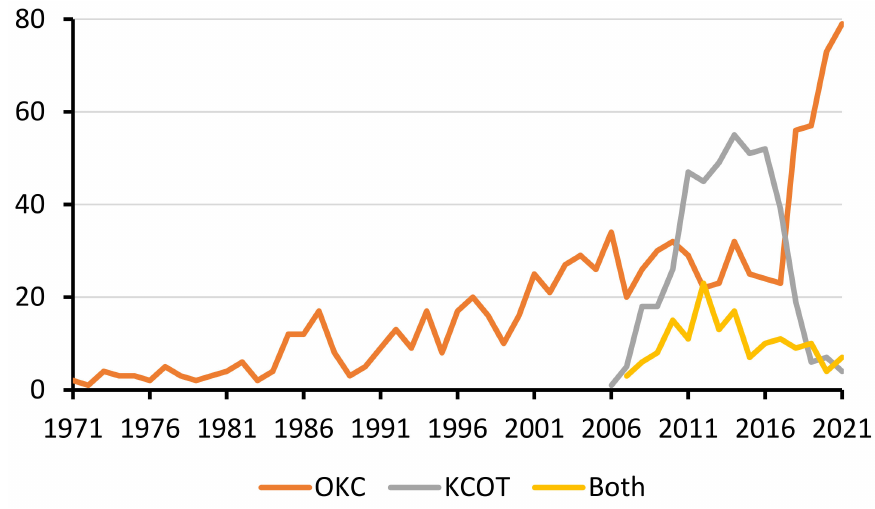
Figure 3. The use of the terms OKC, KCOT, and both in the entire